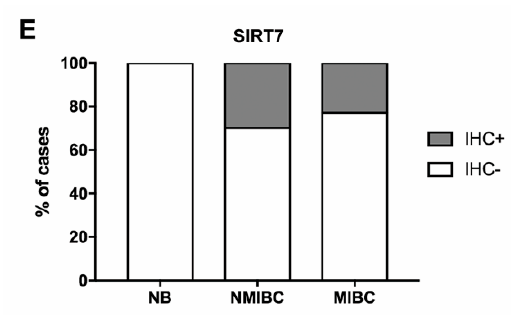
Figure 2. SIRT7 expression downregulation in invasive and TCGA “basal-like” urothelial tumors. Characterization of SIRT7 gene expression in the bladder cancer cohort ( A ) and TCGA cohort ( B ) categorized by clinical grade. Characterization of SIRT7 gene expression in the bladder cancer cohort categorized by non-muscle invasive and muscle invasive bladder cancer ( C ). SIRT7 gene expression according to TCGA molecular clusters analysis in the TCGA cohort ( D ). SIRT7 immunohistochemistry results for the normal and tumor tissue samples cohort, categorized by non-muscle invasive and muscle invasive bladder cancer, regarding the calculated immunoscore ( E ). * p < 0.05, ** p < 0.01, *** p <